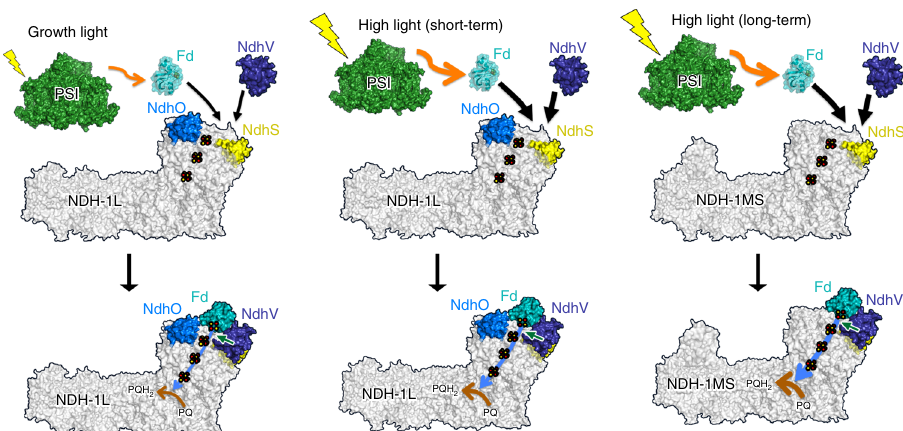
Fig. 6 A schematic model for NDH-1-mediated PSI CET in response to different levels of light exposure. The color scheme is as follows: NdhV, deep blue; NdhS, yellow; NdhO, marine; the rest of NDH-1L and NDH-1MS, gray; Fd, teal; and PSI, green. The electron transfer pathway [2Fe-2S]-N6a-N6b-N2- PQ and the reduction of PQ to PQH 2 are denoted by sky-blue and orange arrows, respectively. The high-light intensity increases the level of photoreduced Fd from PSI (orange arrow between PSI to Fd) and the level of Fd bound to the NDH-1 complex (black arrow between Fd and NDH-1L or NDH-1MS). Positive regulation of NDH-CET by NdhV is indicated by a green